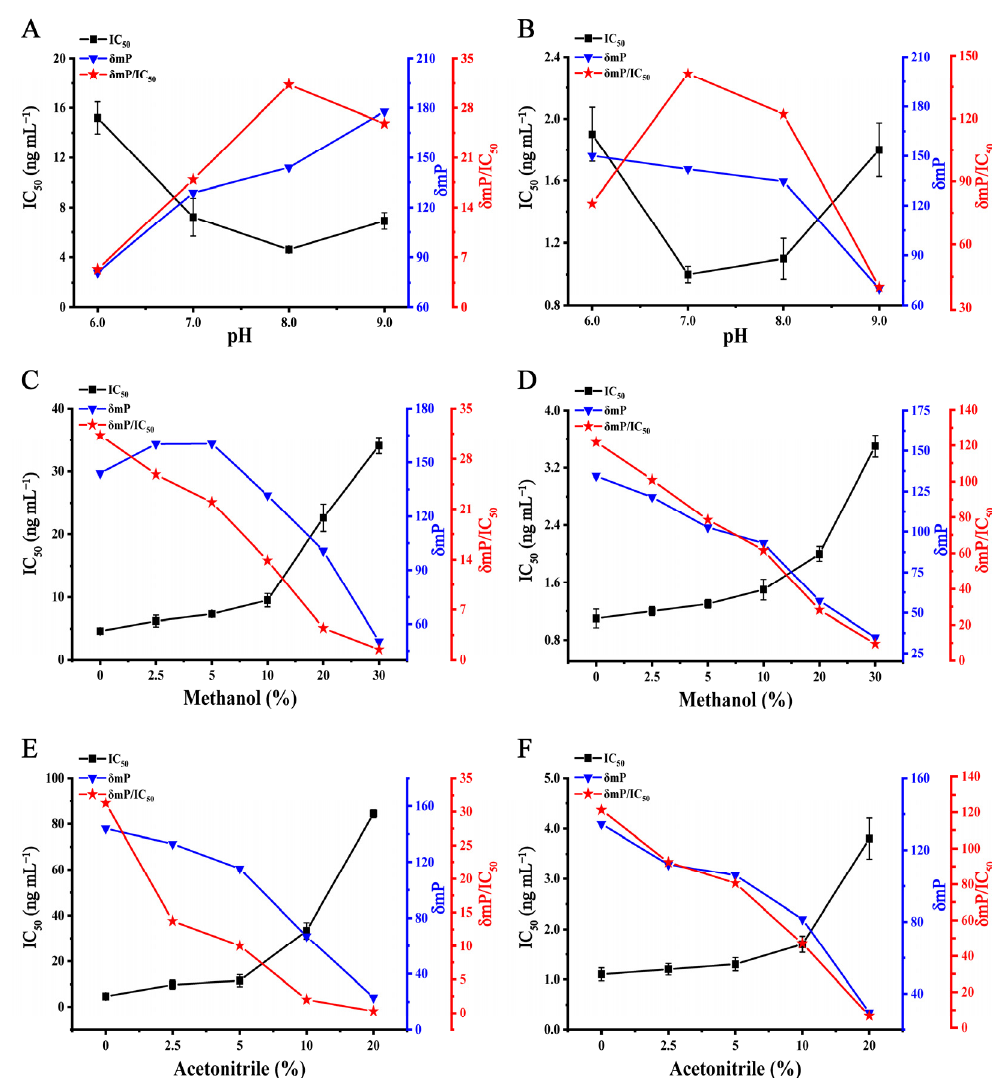
Figure 4. Influence of pH in BB on DWFPIA for SMZ ( A ) and TMP ( B ). Methanol tolerance of DWFPIA for SMZ ( C ) and TMP ( D ). Acetonitrile tolerance of DWFPIA for SMZ ( E ) and TMP ( F ).